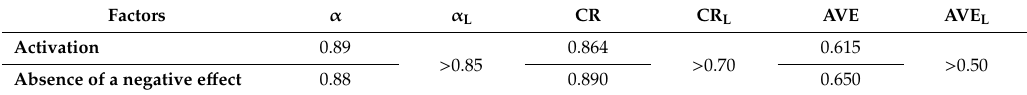
Table 2. Reliability analysis of the scale and factors used.